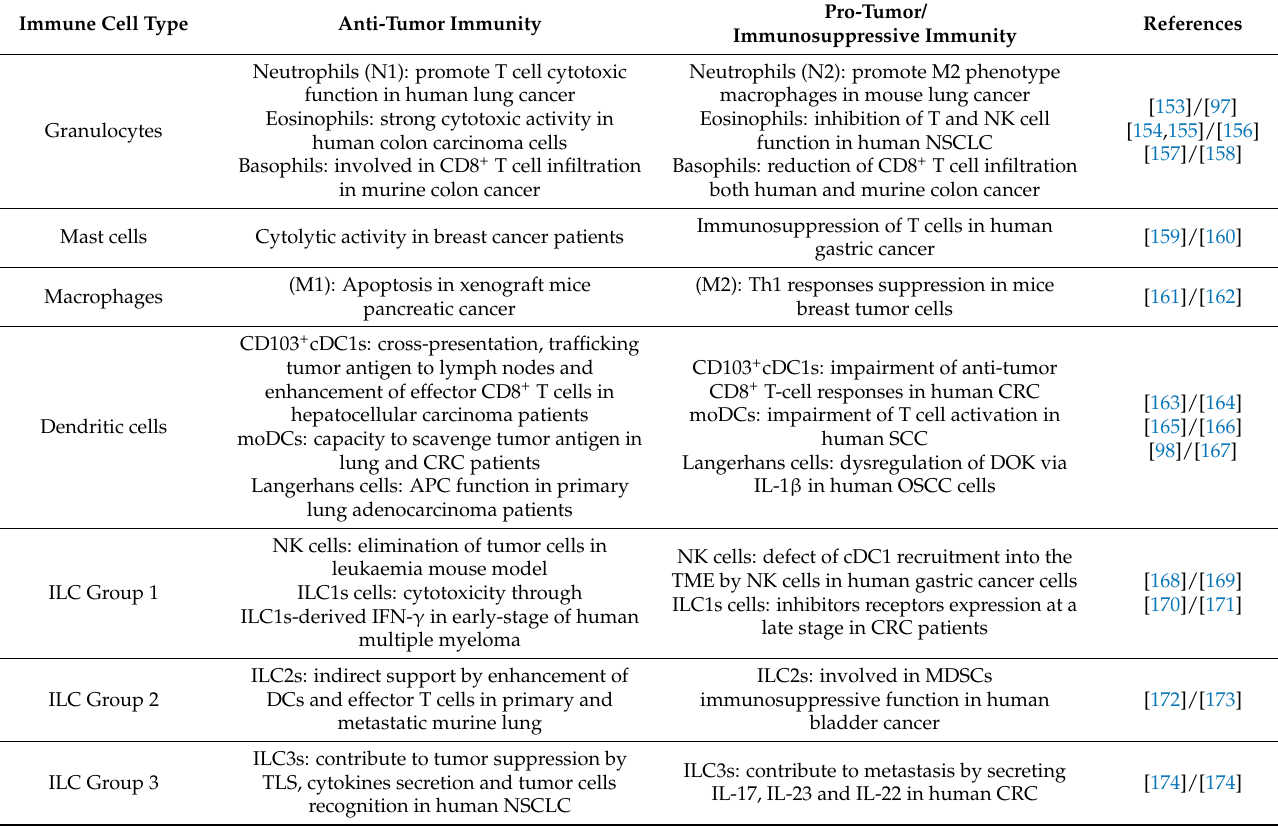
Table 1. Innate immunity. Anti- and pro-tumor functions of the immune cells in different cancer types. Immune Cell